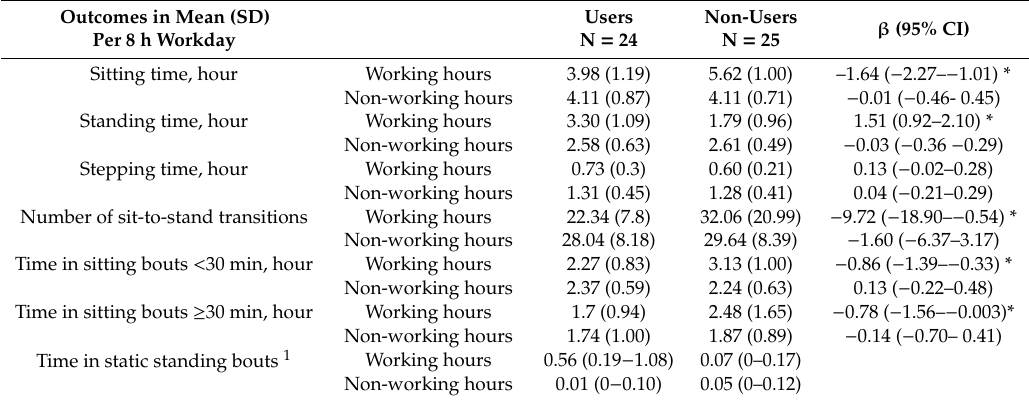
Table 2. Movement behaviour outcomes for working and non-working hours and di ff erences between users and non-users ( β ) including 95% confidence intervals (95%